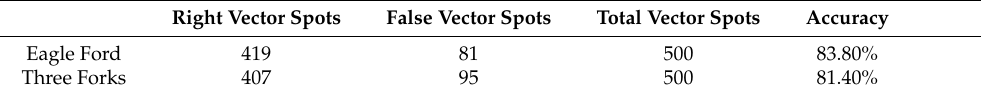
Table 3. Results of the accuracy verification derived from 500 random shale oil/gas vector